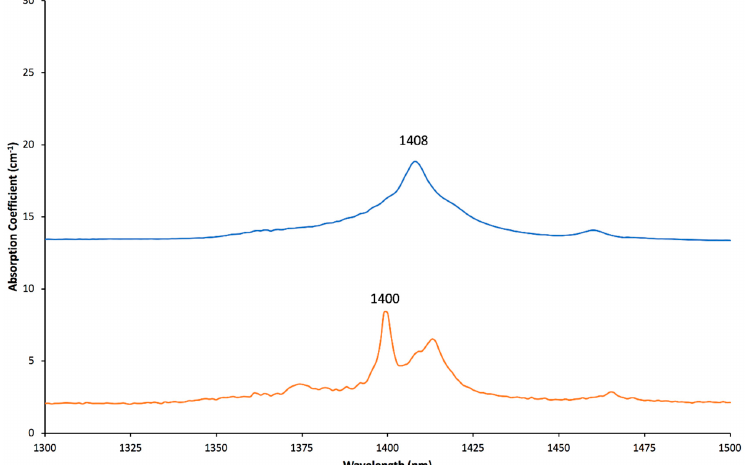
Figure 17. NIR polarized spectra of an emerald from Afghanistan. The light blue and orange lines are for the o ‐ ray and e ‐ ray spectra, respectively. The upper spectrum has been vertically offset for clarity.